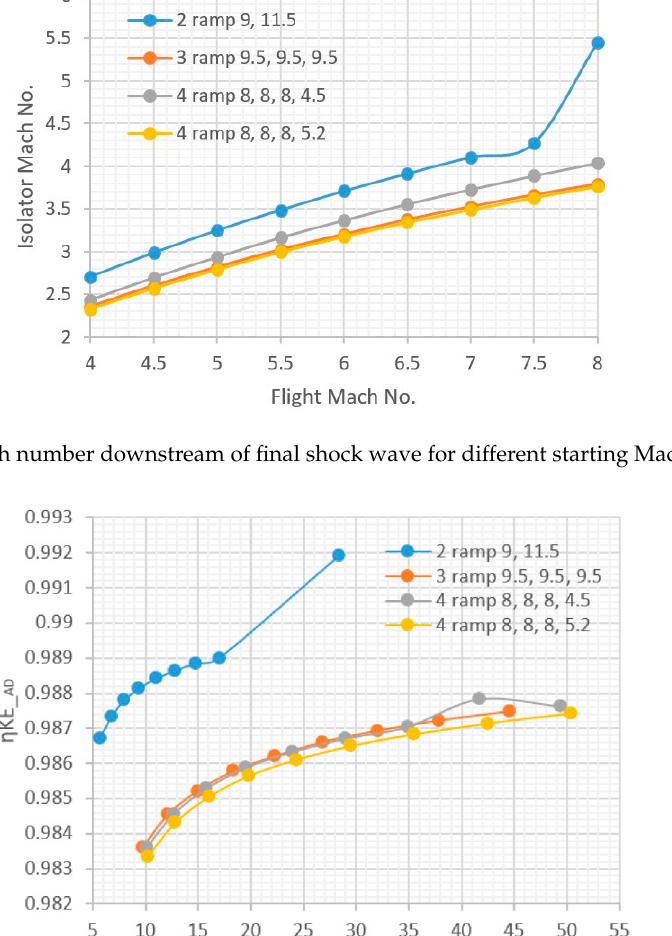
Figure 20. Theoretical compression and pressure recovery of the inlets. The pressure recovery trend decreases with increasing Mach number for all inlet designs because at higher flow speeds the flow is more abruptly decelerated after passing through an oblique shock wave. The level of compression achieved by the inlet improves with increasing number of ramps because each oblique shock wave generates a specific level of compression (greater than 1).